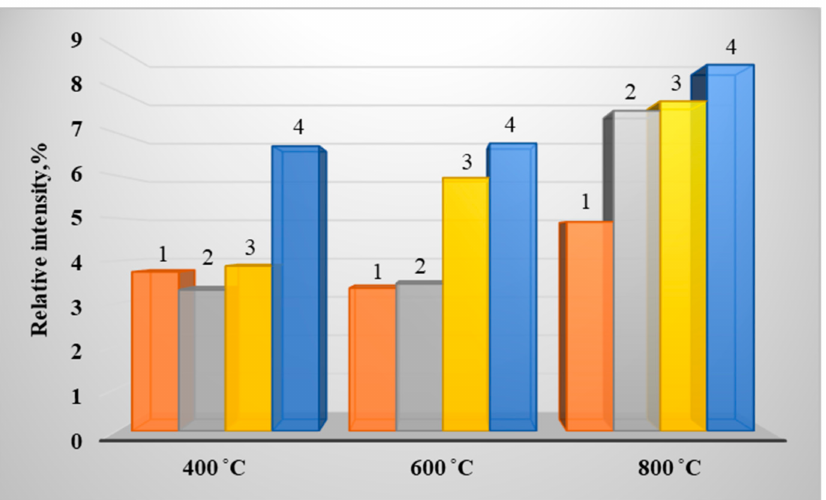
Figure 4. Change in the content of calcium sulfate in mixtures of ash from a set of (5 + 1) particles of grade 3B coal and wood during pyrolysis in the temperature range from 400 ◦ C to 800 ◦ C: 1. Coal 3B_100%; 2. Coal 3B_90%/Wood_10%; 3. Coal 3B_75%/Wood_25%; 4. Coal